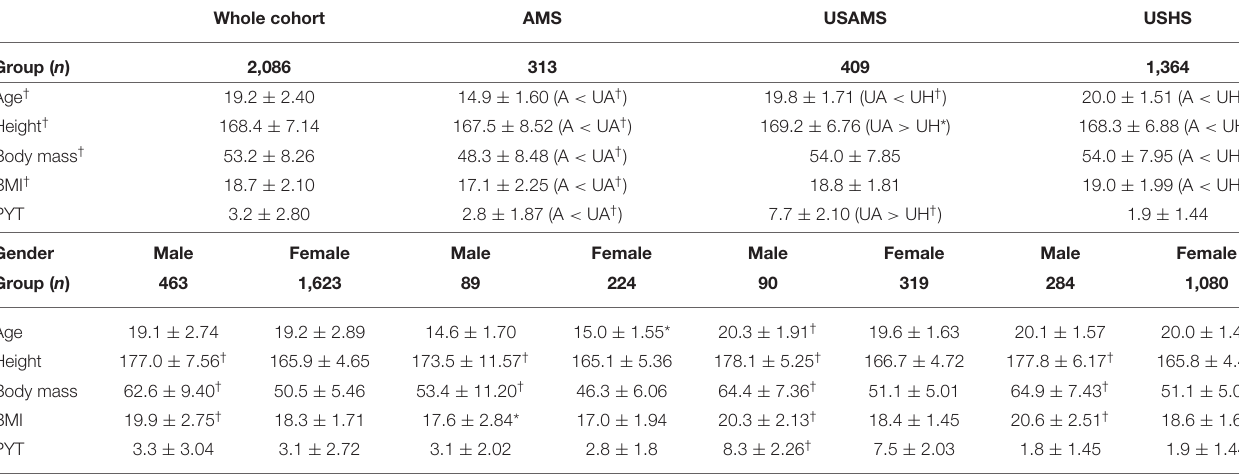
TABLE 1 | Respondent descriptive data: anthropometrics and dance training background. Whole cohort USAMS USHS